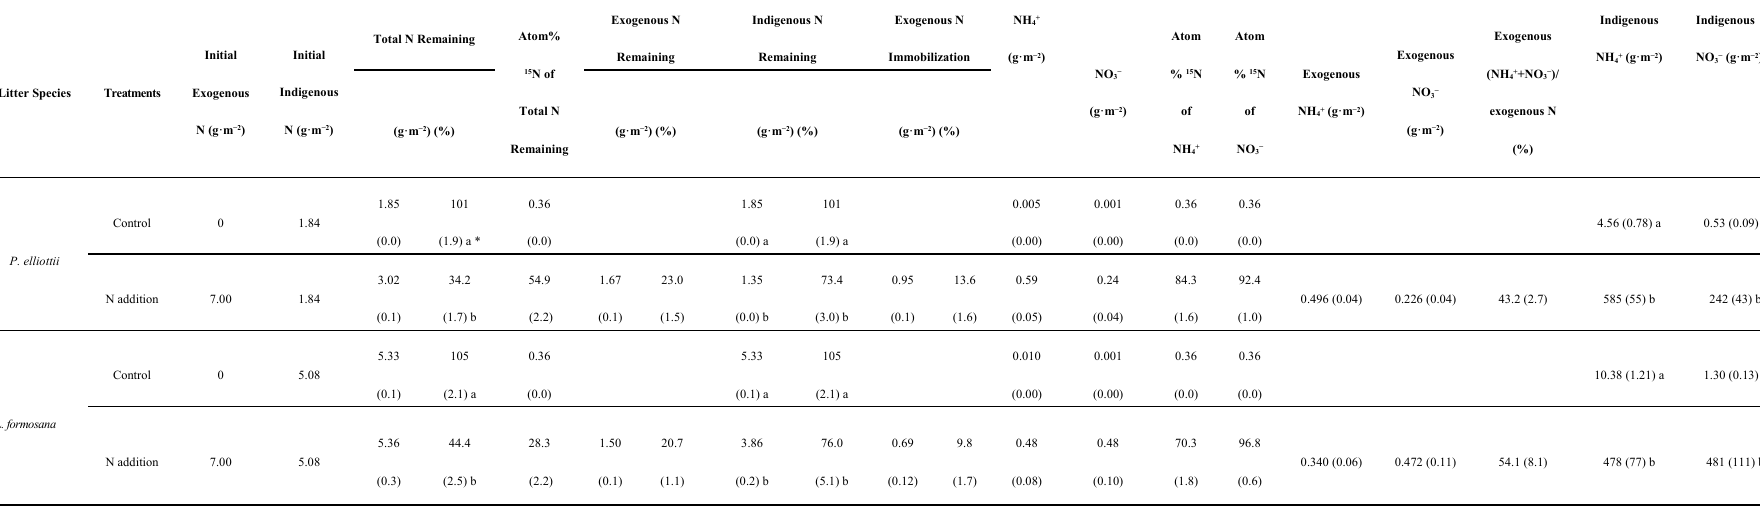
*: Different lowercase letters in the same column of the same species denote significant difference between treatments at 0.05 level. Exogenous N immobilization indicates the portion of exogenous N present in organic